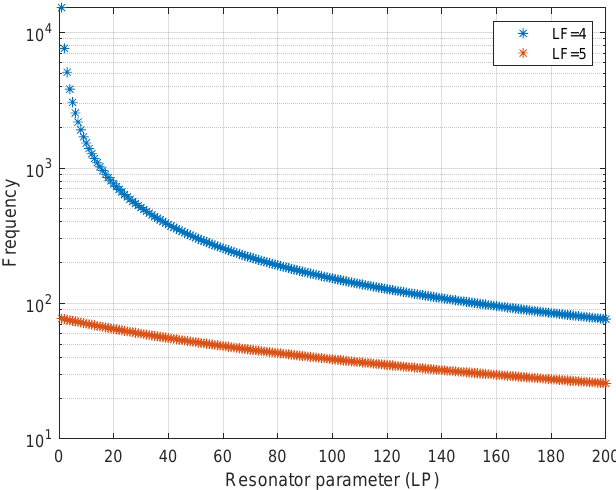
Figure 10. Resonators’ detection frequencies as a function of LP and LF. The effect of the number of SN-MFCC coefficients on the classification accuracy has been investigated using 100, 150, and 200 resonators (each composed of 17 neurons). Figure 11 depicts the classification accuracy as a function of the number of SN-MFCC coefficients (for 100, 150, and 200 resonators) and the number of training epochs (for 5, 10, 12, 15, 20, and 25 epochs). An epoch refers to one cycle through the full 200 samples training dataset. Training the network with more epochs leads to better generalization and improved classification accuracy. The average test accuracy achieved with 20 epochs is 87.23%, 97.11%, and 98.73% for 100, 150, and 200 SN-MFCC coefficients, respectively.